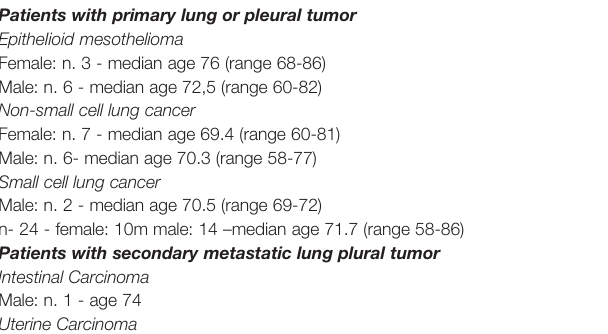
TABLE 1 | Features of patients included in the study. Patients with primary lung or pleural tumor EpitheIioid